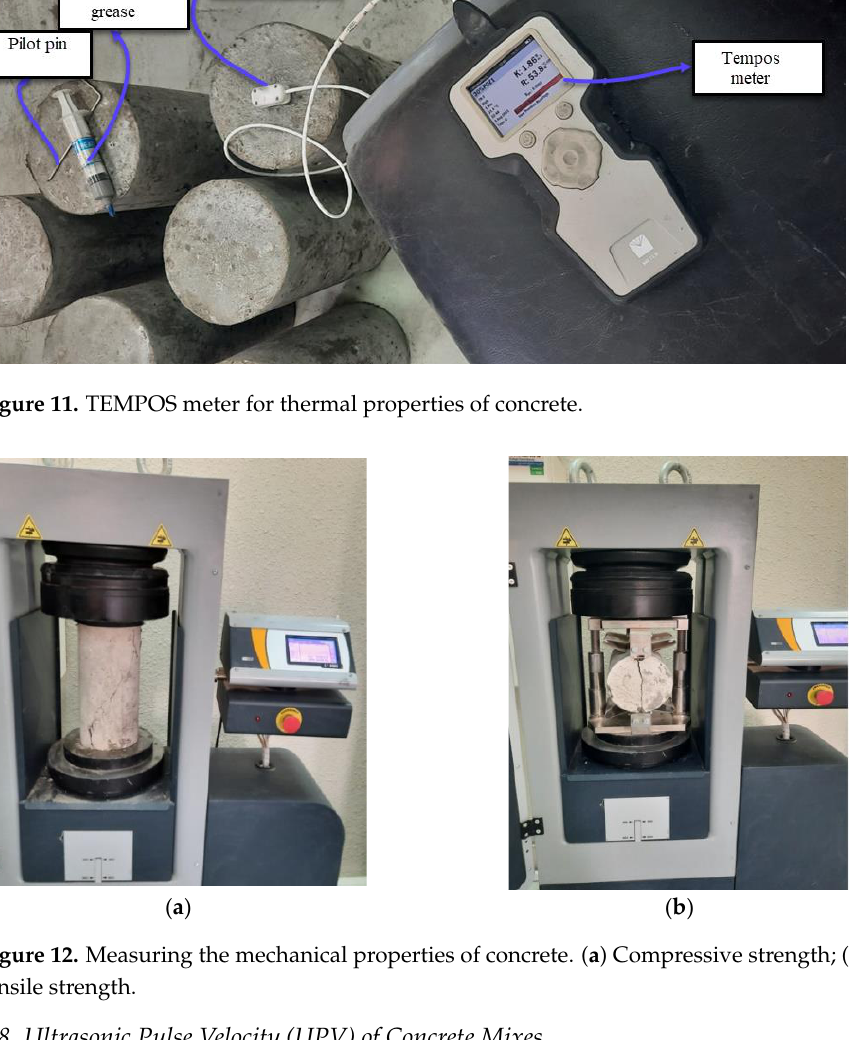
Figure 13. UPV of the concrete mixes. 3. Results and Discussion 3.1. Workability and Density of Concrete Mixtures Workability refers to how easily and consistently a freshly made concrete mix can be poured, compacted, and finished. The workability of concrete improves as the water – ce- ment ratio increases and is generally measured by conducting slump tests on fresh con- crete [49,50]. The slump values for the twelve concrete mixes were measured according to